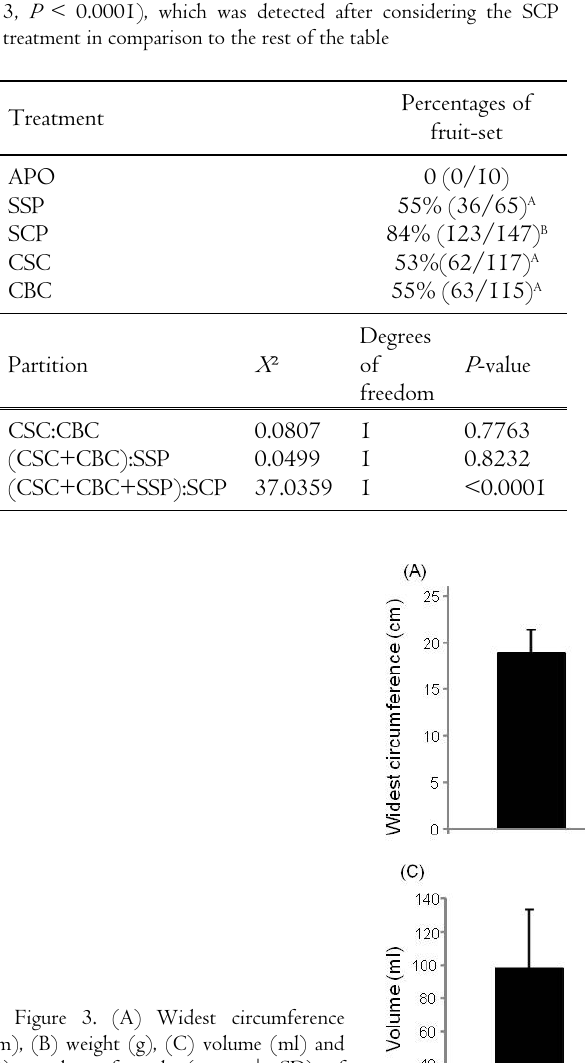
Figure 3. (A) Widest circumference (cm), (B) weight (g), (C) volume (ml) and (D) number of seeds (mean ± SD) of tomatoes from experiments of open- pollination and spontaneous self-pollination in open-field crops in 2012.